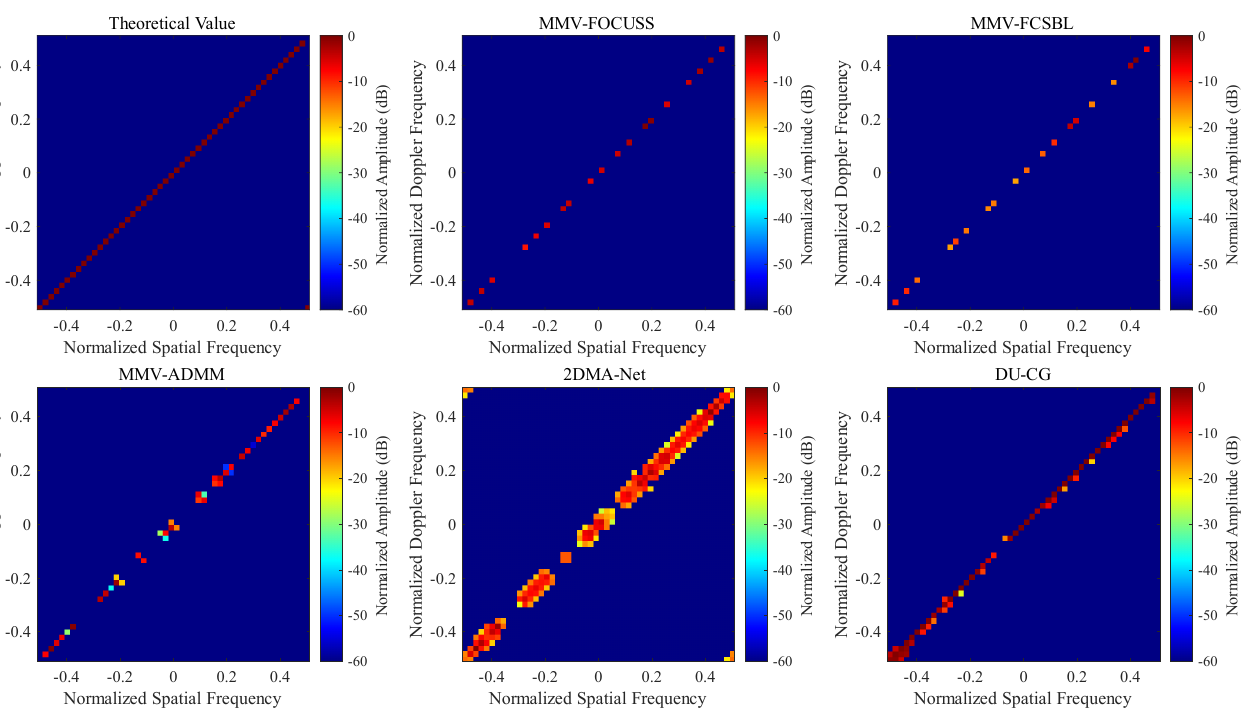
( b ) Figure 7. Network training convergence results: ( a ) training loss curves of 2DMA-Net and Cy- cleGAN and ( b ) discrimination probability curves of the discriminator G Z . 4.2. Clutter Spectrum Estimation In this subsection, the clutter spectrum estimation results of the proposed DU-CG network are presented under different situations. For comparison, the results obtained via MMV-FOCUSS, MMV-FCSBL, and MMV-ADMM are also shown. As a reference, the MVDR clutter spectrum is calculated based on the theoretical CNCM.